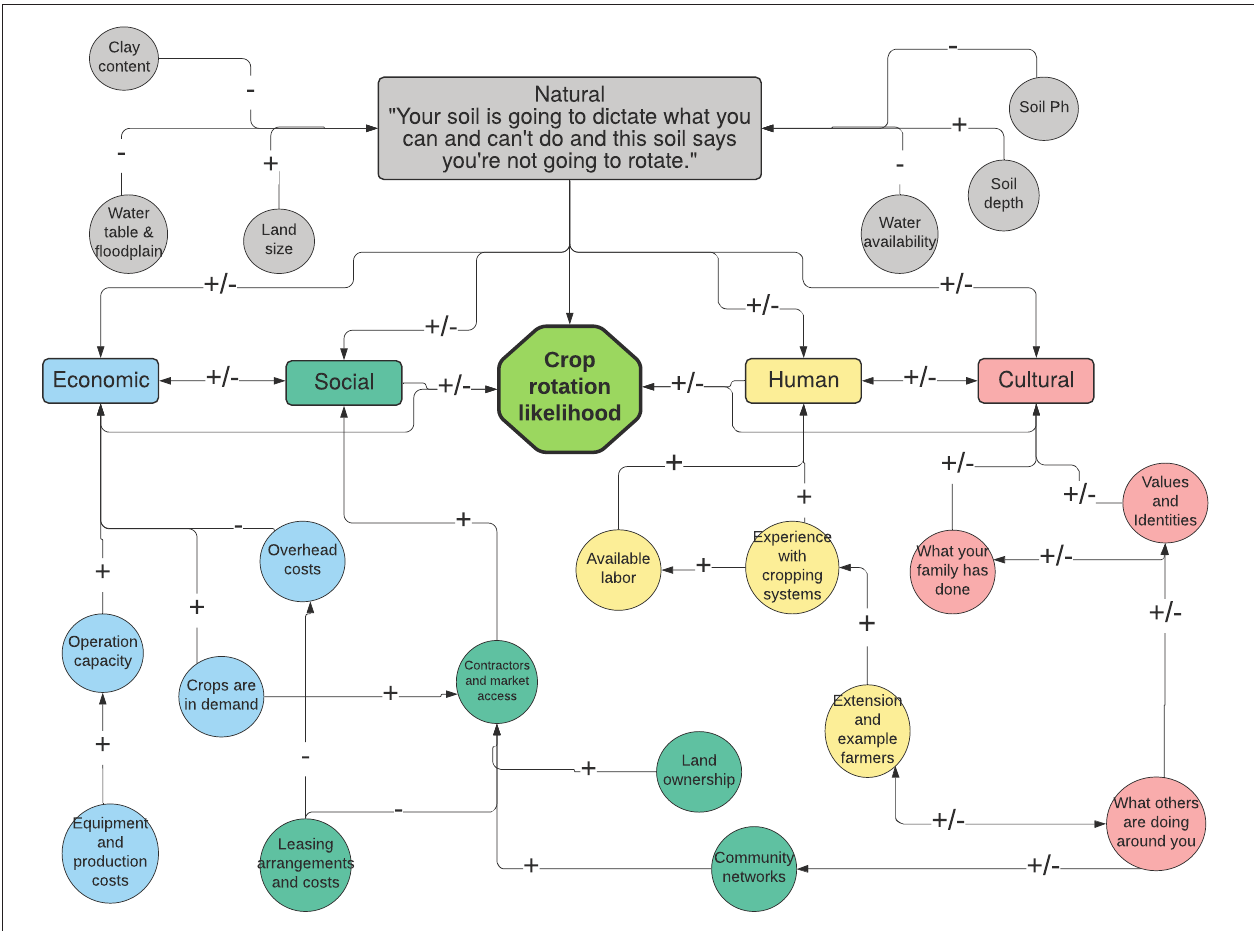
FIGURE 4 | A conceptual model demonstrating major assets for rice production and their influential conditions affecting the possibility for crop rotation. Natural capital is foundational and largely influence the other four. Secondary capitals were grouped into Economic, Social, Human, and Cultural categories ( Flora et al., 2019). These capitals are interdependent on each other, depicted by the direction and connectivity of the arrows. Conditions that influence capitals are depicted as circles. The direction of the arrows indicates what they influence, and whether the relationship is positive or negative in terms of increasing or decreasing the likelihood of crop rotations, respectively. Some influential conditions such as “What your family has always done” can be either positive or negative depending on the growers’